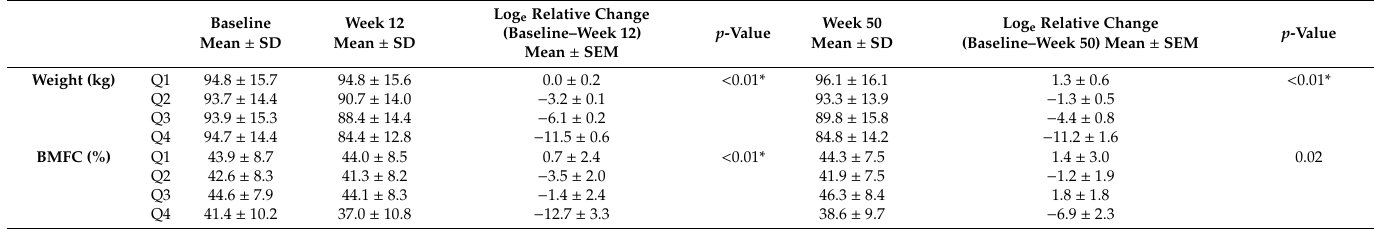
Table 3. Mean values and relative change (%) of weight and BMFC in week 12 and week 50 across the weight loss quartiles compared with the baseline values, n =